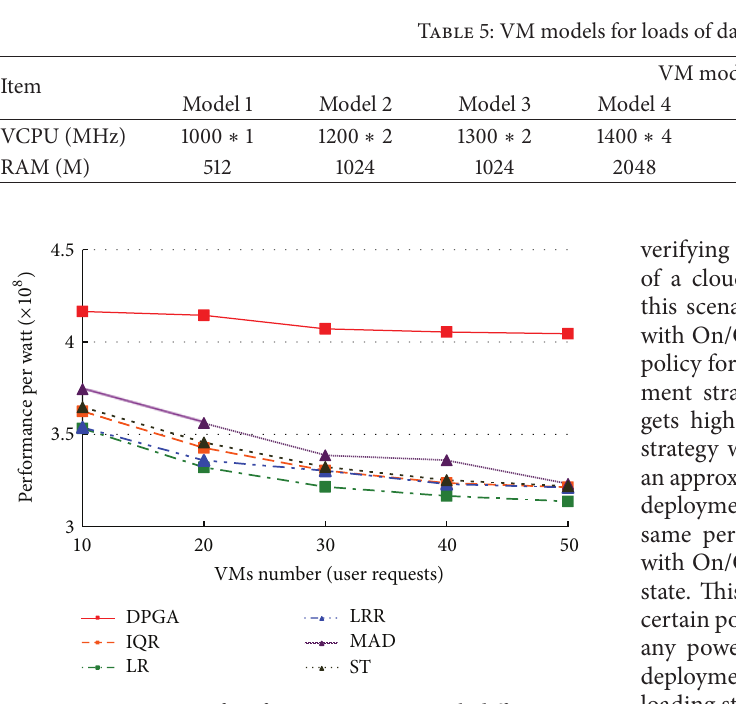
Figure 3: Comparison of performance per watt with different user